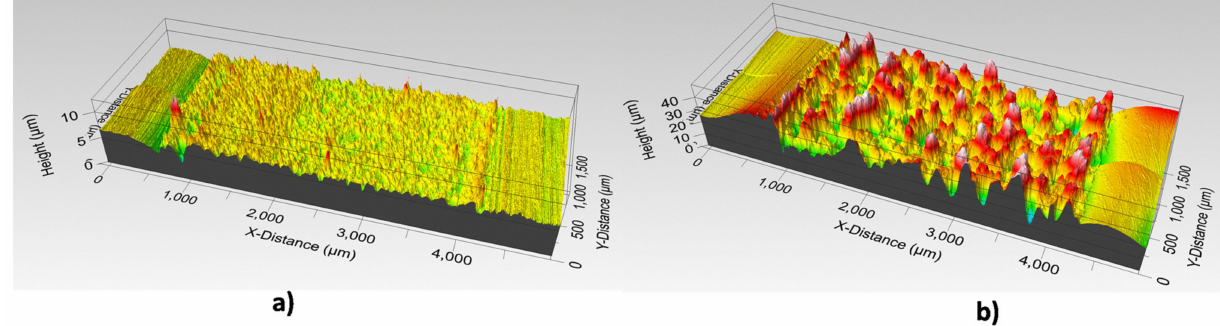
Figure 9. 3D profilometry of a section of the pattern printed with ( a ) DuPont PE873 ink and ( b ) Inkron IPC-603X on the PET thermosetting